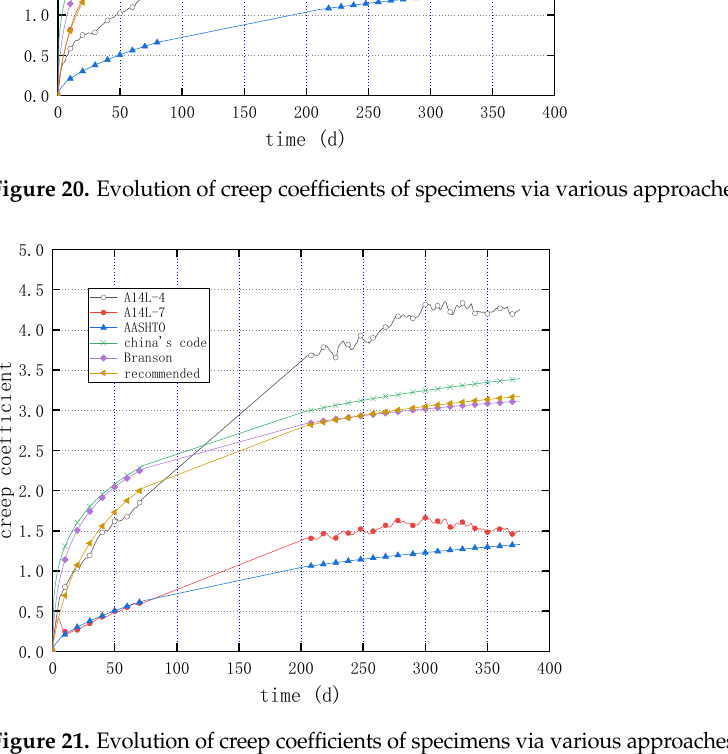
Figure 21. Evolution of creep coefficients of specimens via various approaches (loading age of 14 days).